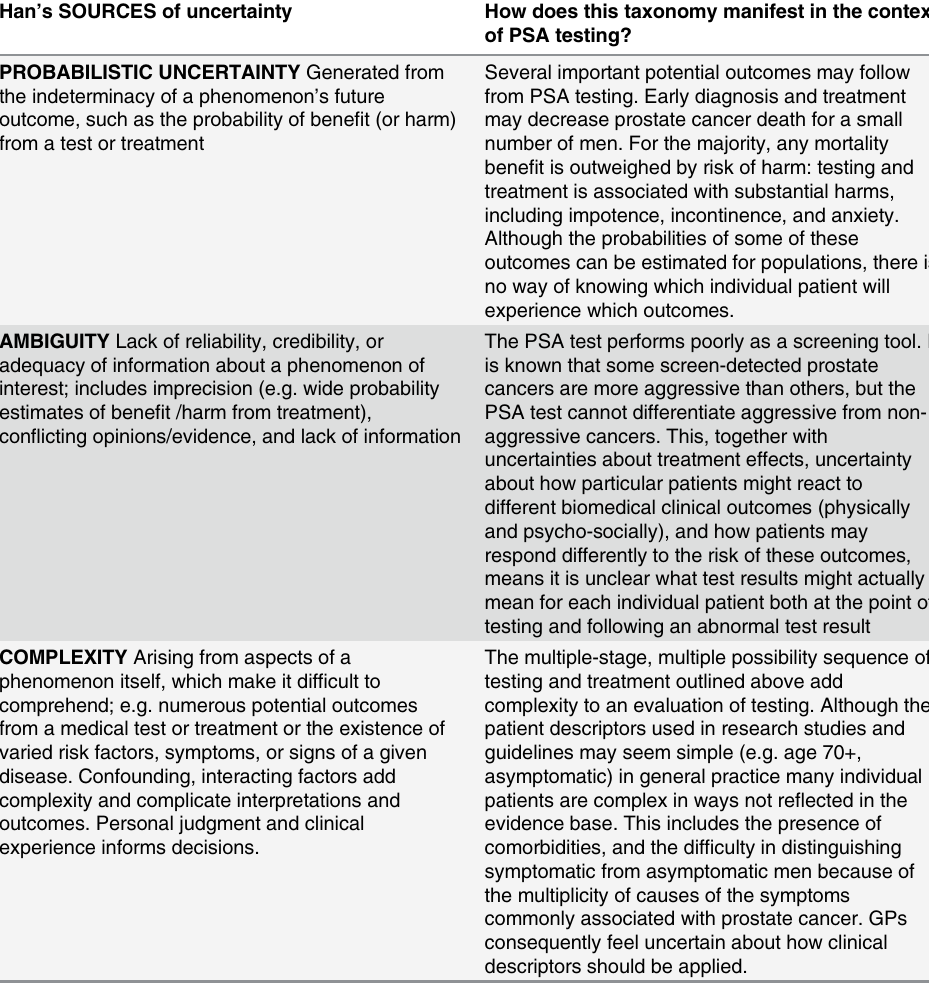
Table 1. Sources of uncertainty (where is GP uncertainty coming